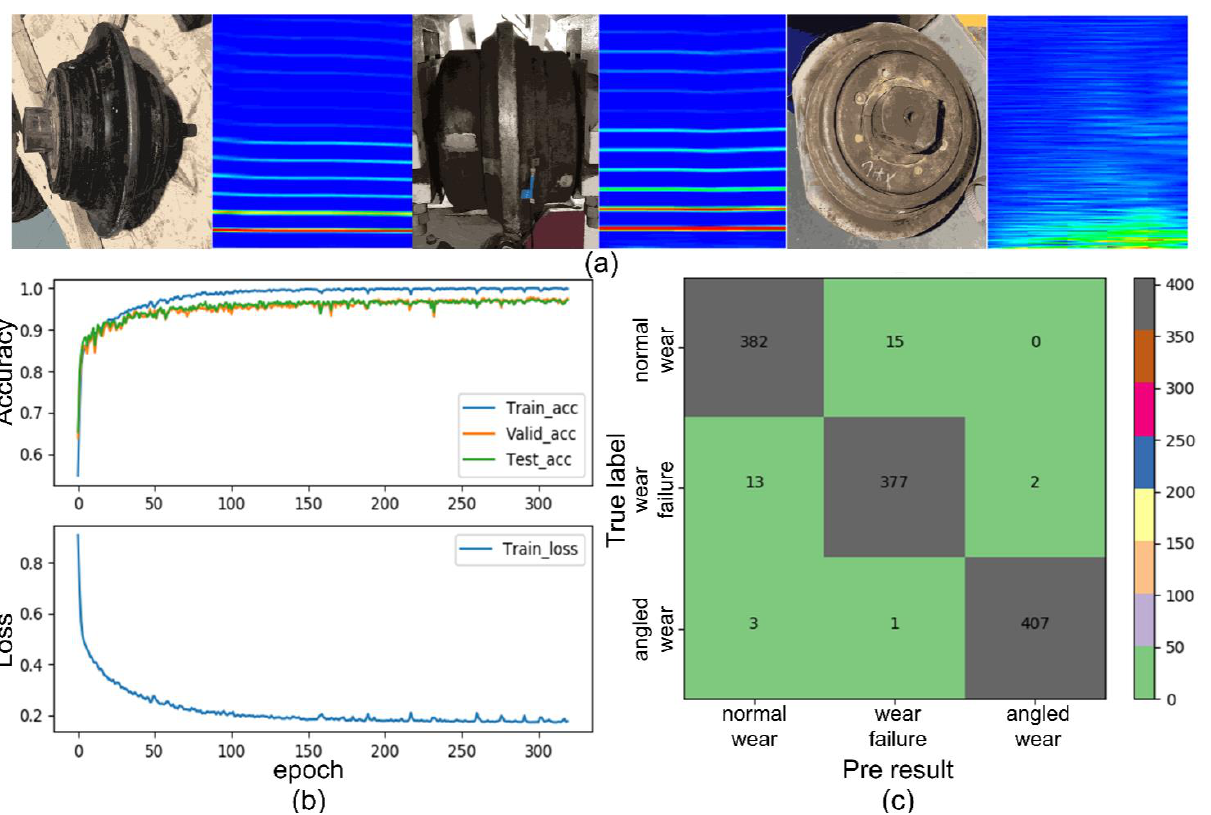
Figure 9. Neural network model recognizes cutter wear status based on frequency domain characteristics: ( a ) correspondence between vibration characteristics and wear status; ( b ) model accuracy and loss; ( c ) comparison of forecast results. Each background color corresponds to a numerical range, and the background color indicates the number of occur-rences of each